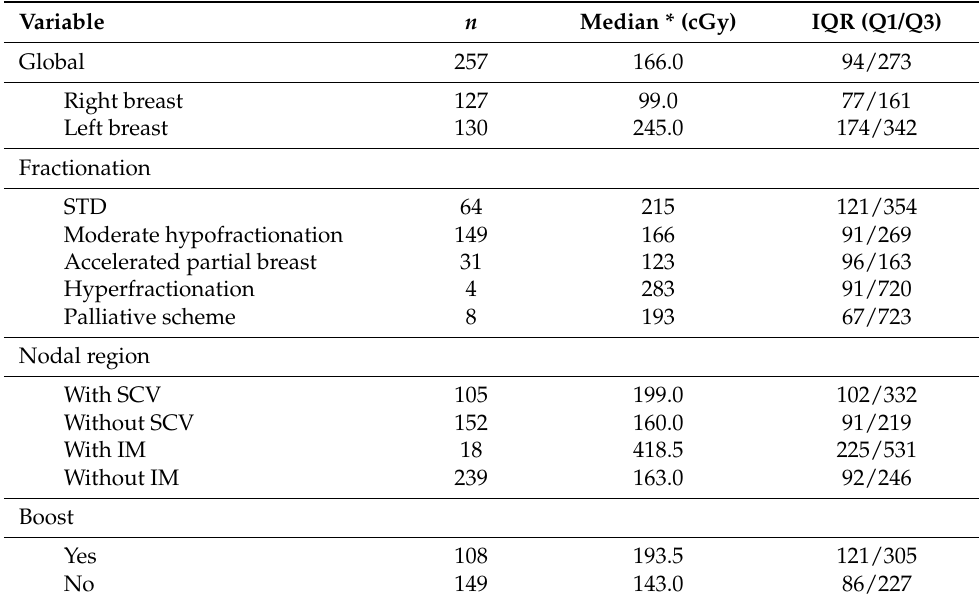
Table 2. Treatment volume, fractionation, and corresponding cardiac dose.